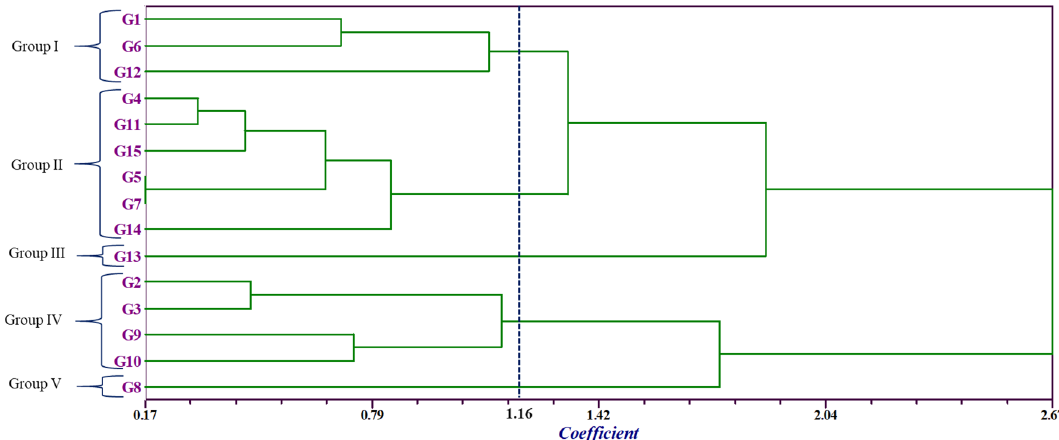
Figure 6. Dendrogram showing the relationship among the Bambara groundnut landraces revealed by non- overlapping (SHAN) UPGMA